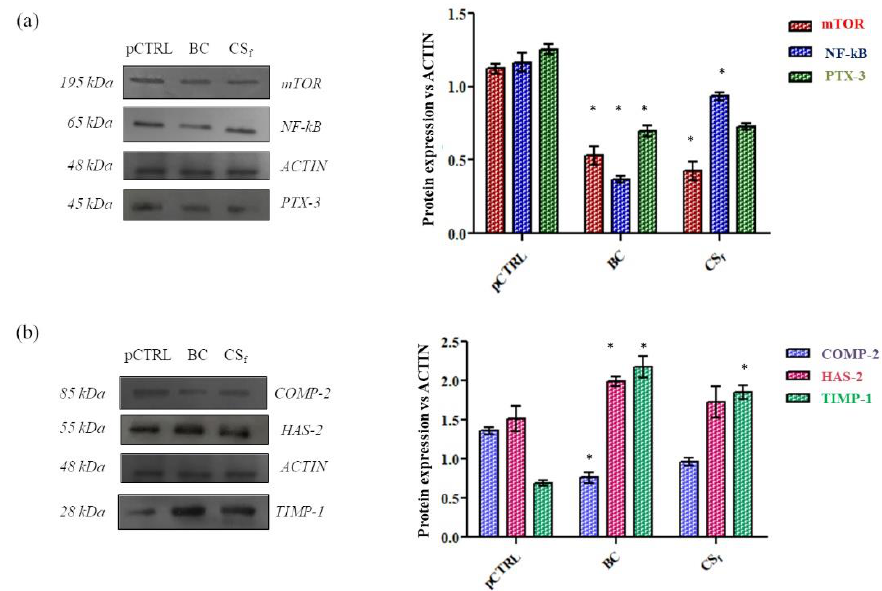
Figure 3. Western blot analysis in CS- and BC-treated OA synoviocytes. ACTIN was used as the loading control. ( a ) Biomarkers related to inflammatory process; ( b ) Biomarkers involved in remodeling and/or regeneration of cartilage. Relative changes of treated samples vs. pCTRL are reported as mean + SD. * p < 0.05.